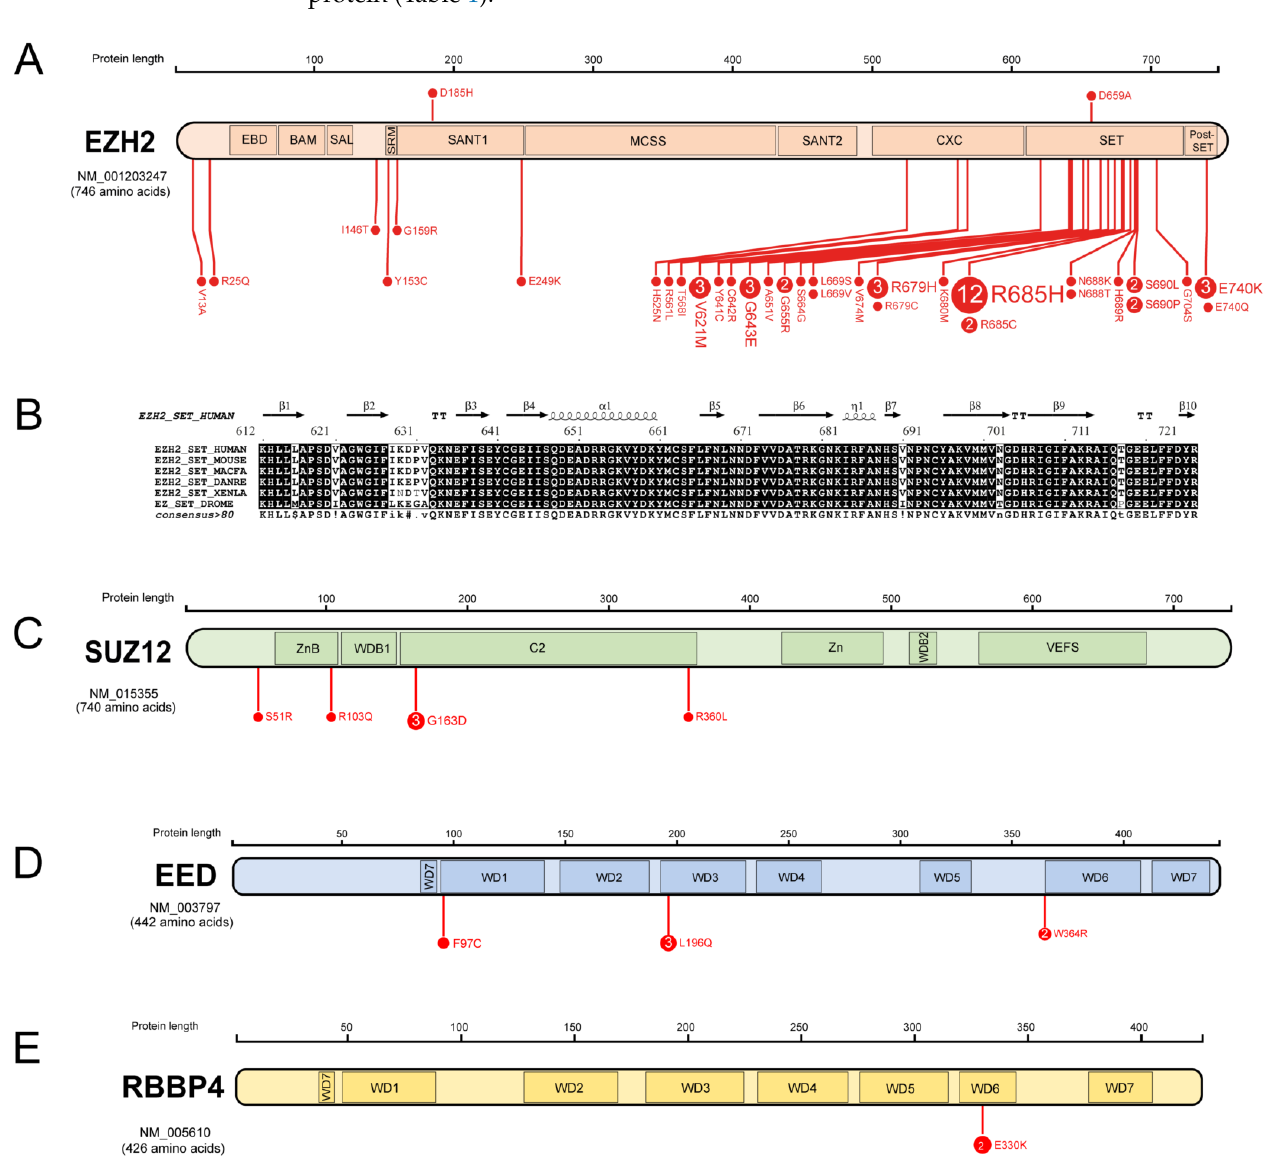
Figure 3. Missense mutations seen in AML mapped to core PRC2 components. ( A ) EZH2 mutations span the entire coding sequence but are more frequent in the CXC and SET domains that are important for catalysis. ( B ) SET domain sequences from different species reflecting the conservation of residues around AML mutational hotspots. ( C ) Zinc finger binding or ZnB and the C2 domains harbour SUZ12 mutations that may affect the inter and intra-complex interactions. ( D , E ) show the mutations on WD repeats of EED and RBBP4, respectively. Images ( A , C – E ) have been adapted from PeCan ProteinPaint [41], and ( B ) was created using ESPript—https://espript.ibcp.fr on 24 October 2022 [45] .